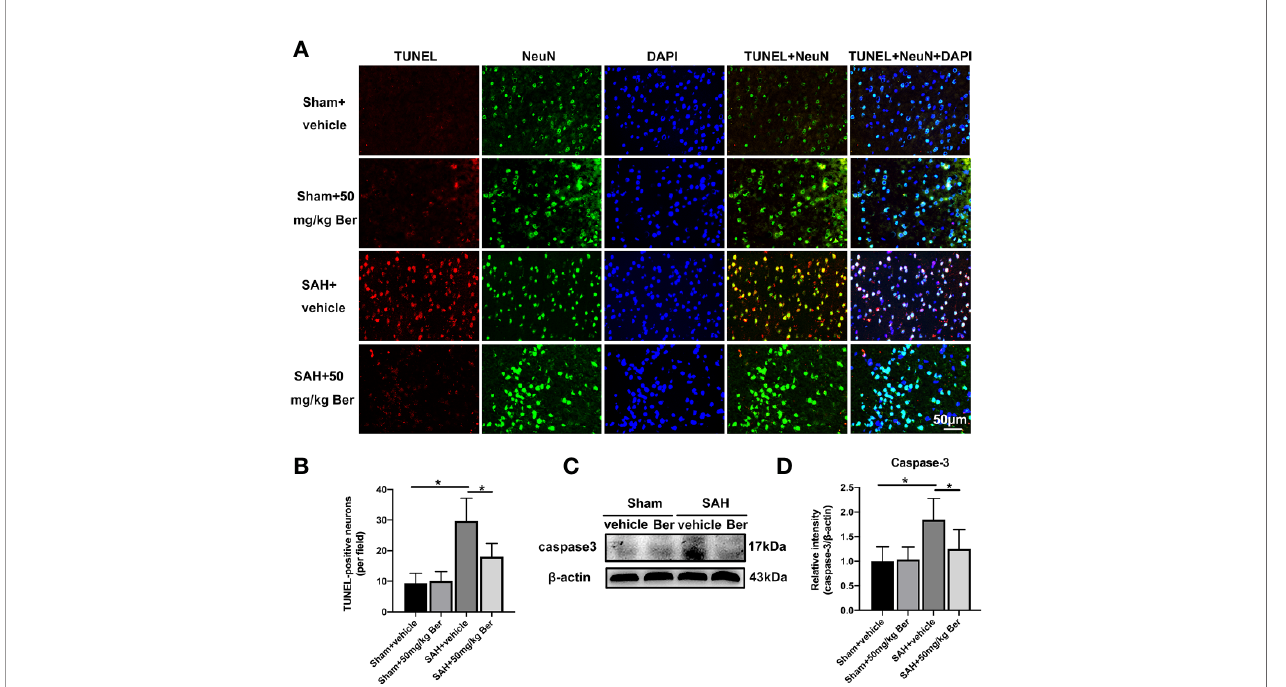
FIGURE 3 | Effects of berberine on neural apoptosis after SAH. (A, B) Representative photomicrographs (A) and quanti fi cation (B) of TUNEL staining. n = 6 per group. (C, D) Western blot assay (C) and quanti fi cation for the expression of caspase-3 (D) in the indicated groups. n = 6 per group. Bars represent the mean ± SD. * P <